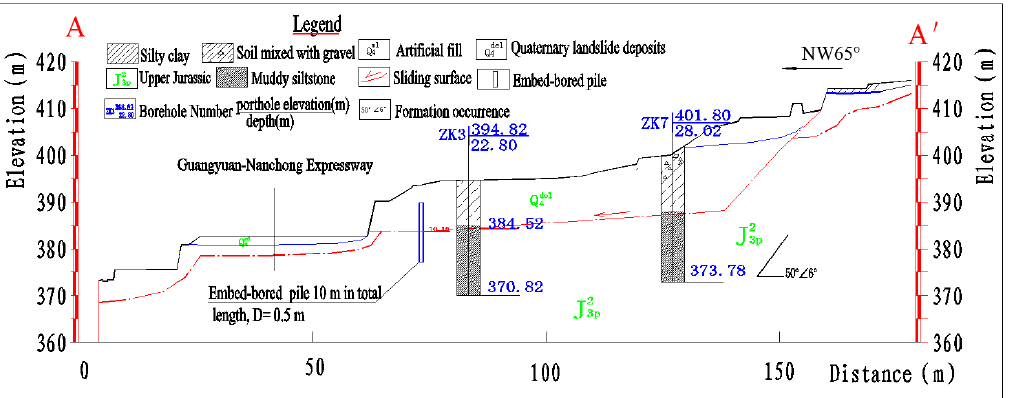
Figure 4. Geology conditions pertaining to the cross-section AA ′ of the Yanzishan landslide obtained via engineering geological survey.